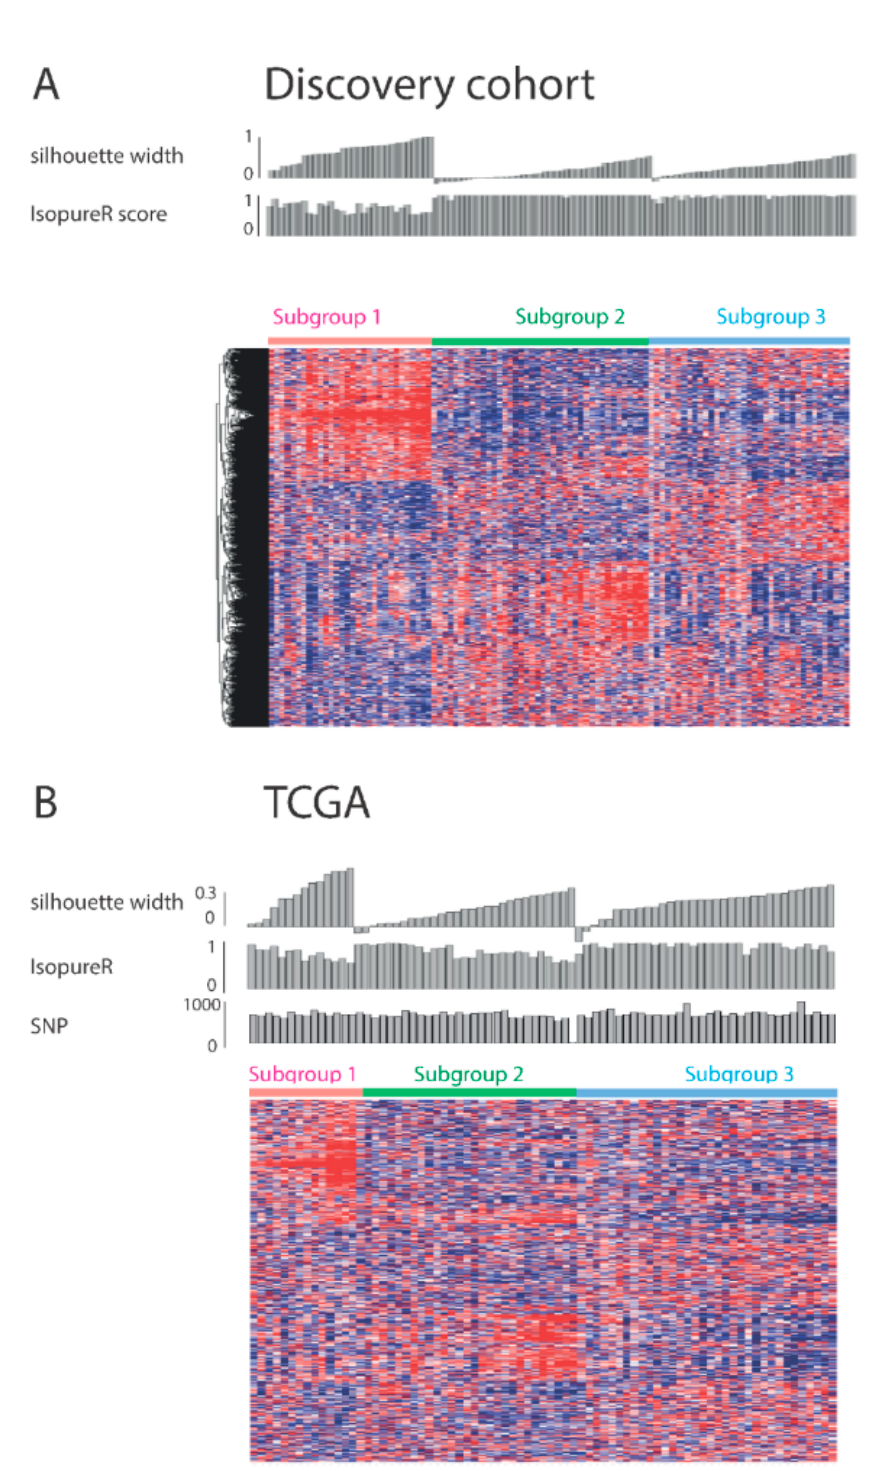
Figure 1. Heatmaps indicating expression levels of the AUMC and TCGA cohorts. Rows with differentially expressed genes ordered by unsupervised clustering in AUMC cohort are shown by the dendrogram at the left of the AUMC heatmap. Columns with EAC RNA-seq profile for each patient are ordered by silhouette width and cluster membership.